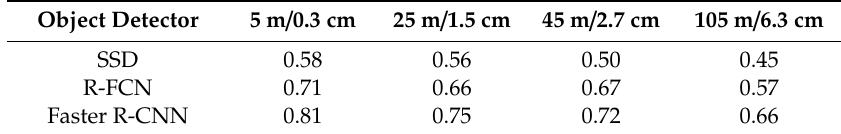
Table 7. Comparison of object detectors between di ff erent resolutions in the first setting, where we trained and evaluated the down-sampled images. The metric is MAP@0.5IoU.